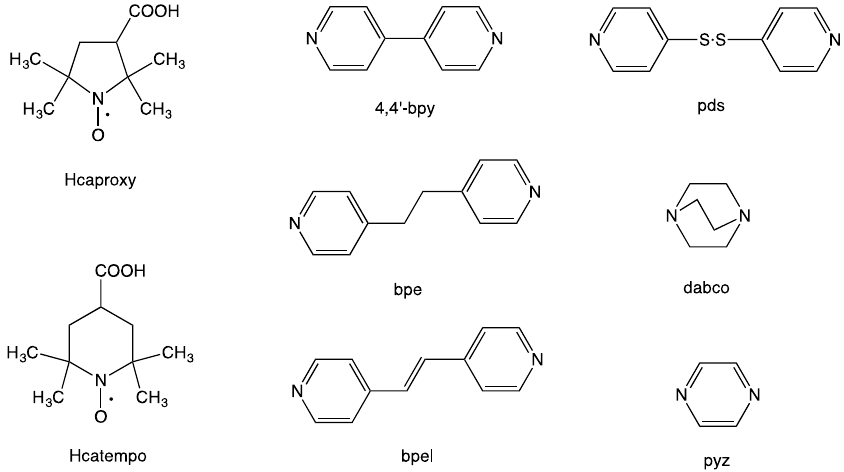
Figure 1. Free radical carboxylic acids, 3-carboxy-2,2,5,5-tetramethyl-1-pyrrolidinyloxy (Hcaproxy) and 4-carboxy-2,2,6,6-tetramethylpiperidinyloxy (Hcatempo), and linking N , N’ -bidentate ligands, 4,4 ′ -bipyridine (4,4 ′ -bpy), 1,2-bis(4-pyridyl)ethane (bpe), trans -1,2-bis(4-pyridyl)ethylene (bpel), 4,4 ′ -dipyridyl disulfide (pds), 1,4-diazabicyclo[2.2.2]octane (dabco), and pyrazine (pyz)).